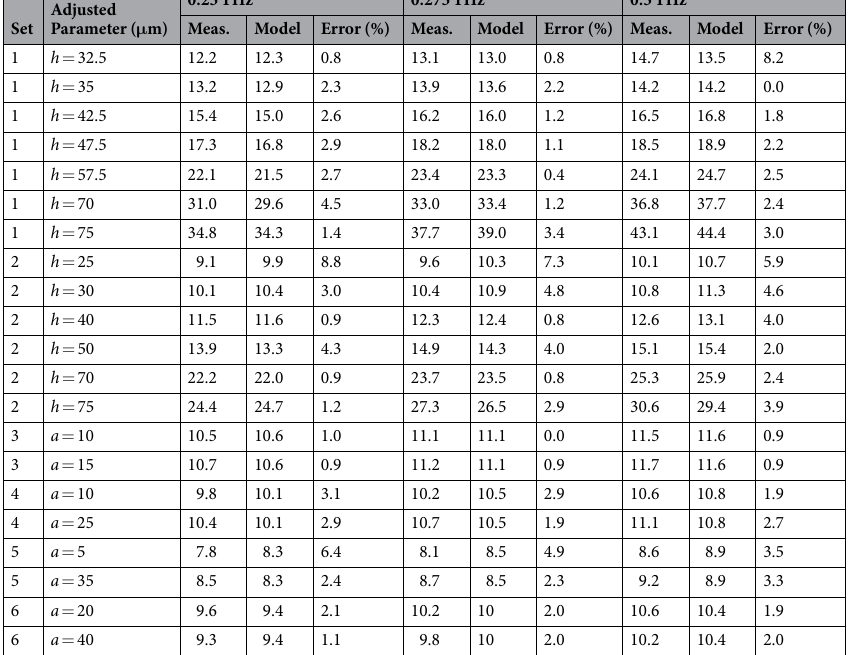
Table 1. The list of the measured WGs and corresponding error rates, model (Model) vs. measurements (Meas.).